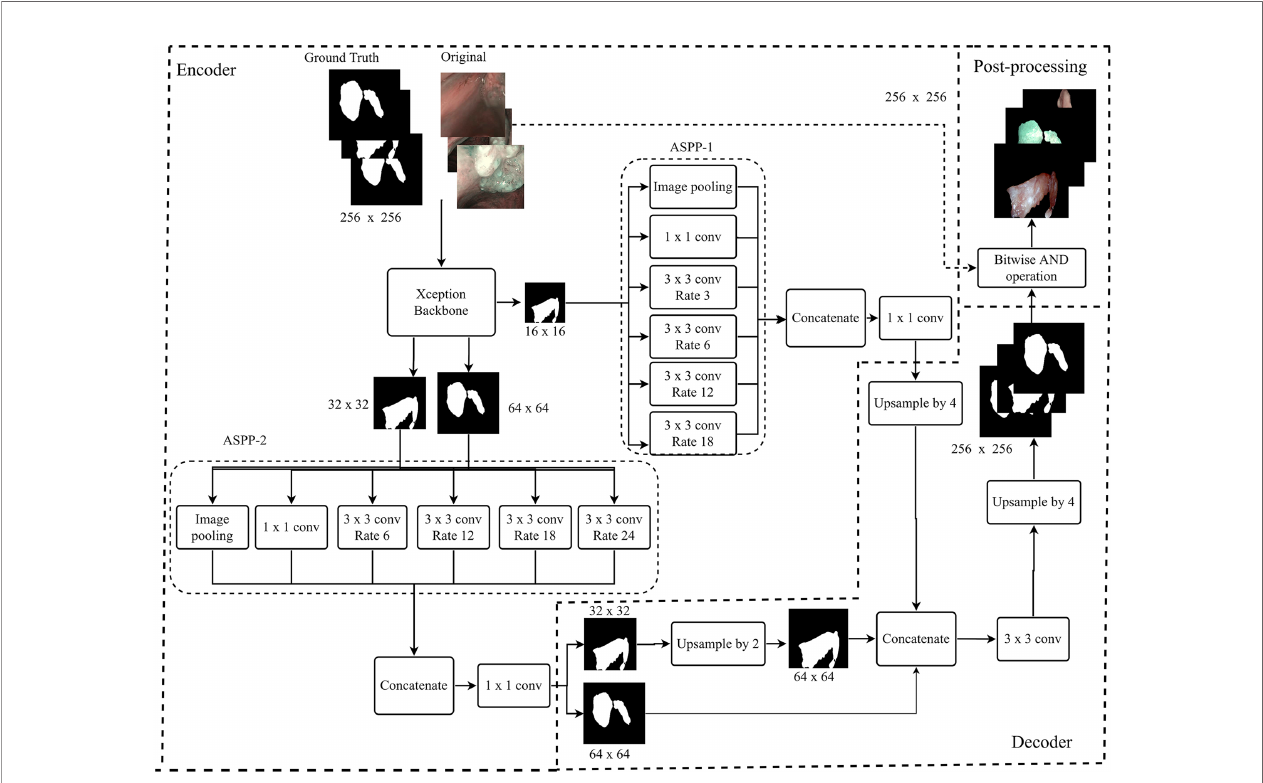
FIGURE 2 | Work fl ow diagram of the proposed SegMENT semantic segmentation architecture. The Xception backbone is customized for segmentation tasks by eliminating the dense layers for classi fi cation while maintaining the feature extraction layers. The model encoder uses two ASPP blocks designed, respectively, for high- and low-level image features. The decoder section concatenates the information coming from the two ASPP blocks, producing segmentation